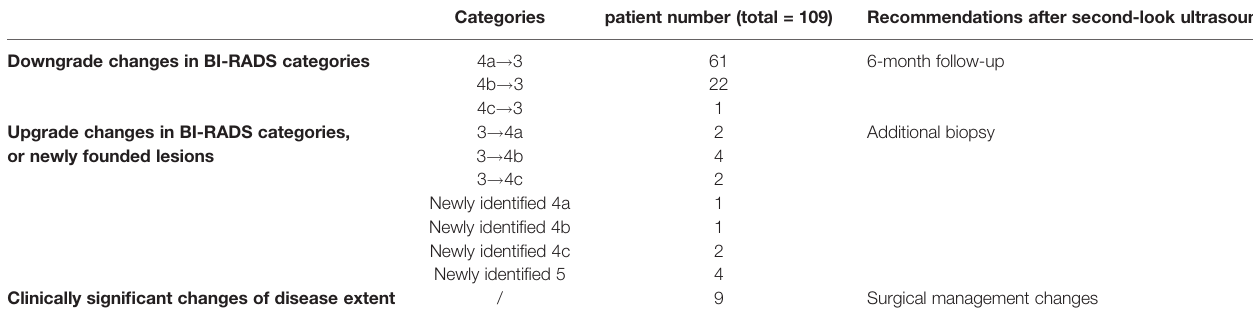
TABLE 2 | Details of lesions with interpretation